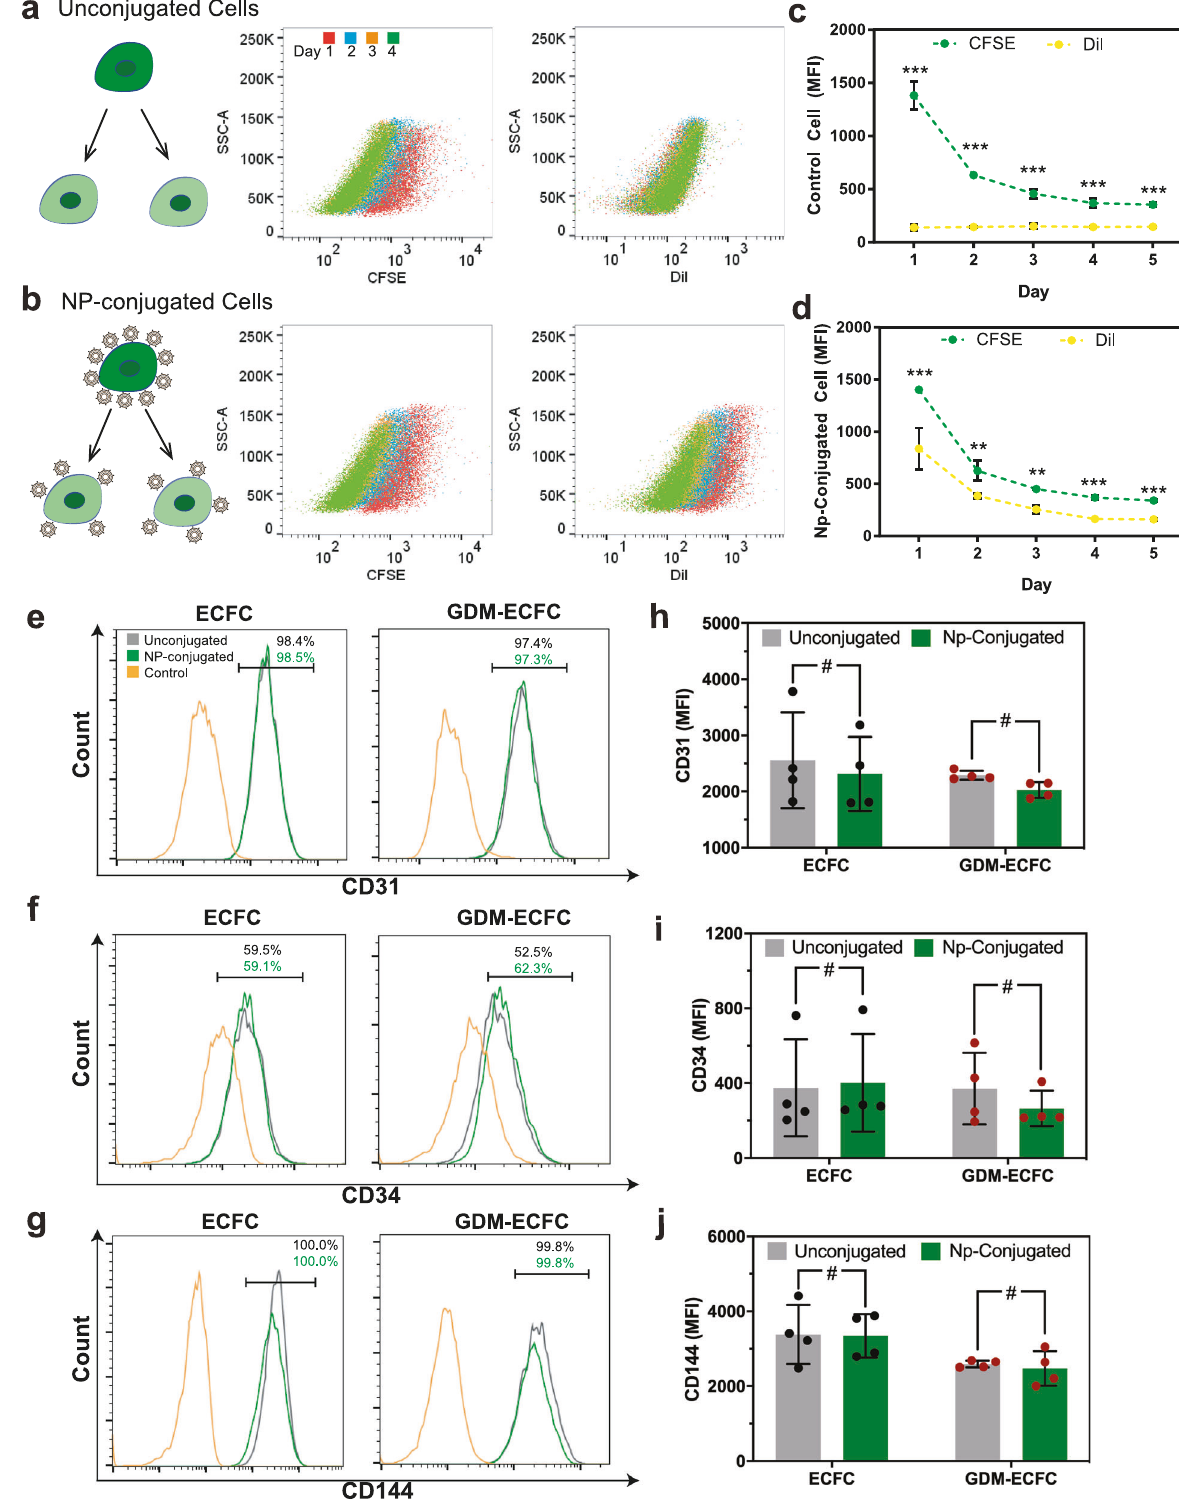
biological replicates, there was no statistical difference between them ( # P = 0.387). In addition, nanoparticle conjugation did not alter expression of CD31, CD34, and CD144 for normal ECFCs and GDM-ECFCs (Fig. 2h – j and Supplementary Fig. 6). Collec- tively, these data suggest that conjugation of nanoparticles does not signi fi cantly alter key functions and phenotypes of